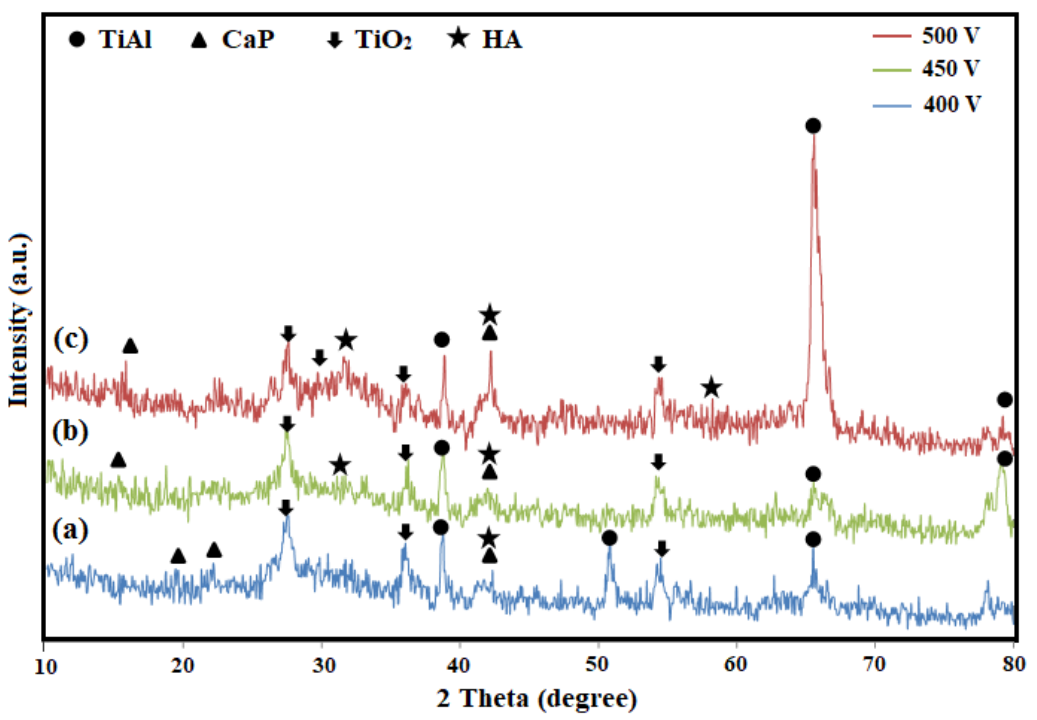
Figure 2. X-ray diffraction (XRD) patterns of PEO-coated γ -TiAl alloy samples prepared under applied voltages of ( a ) 400 V, ( b ) 450 V, and ( c ) 500 V.